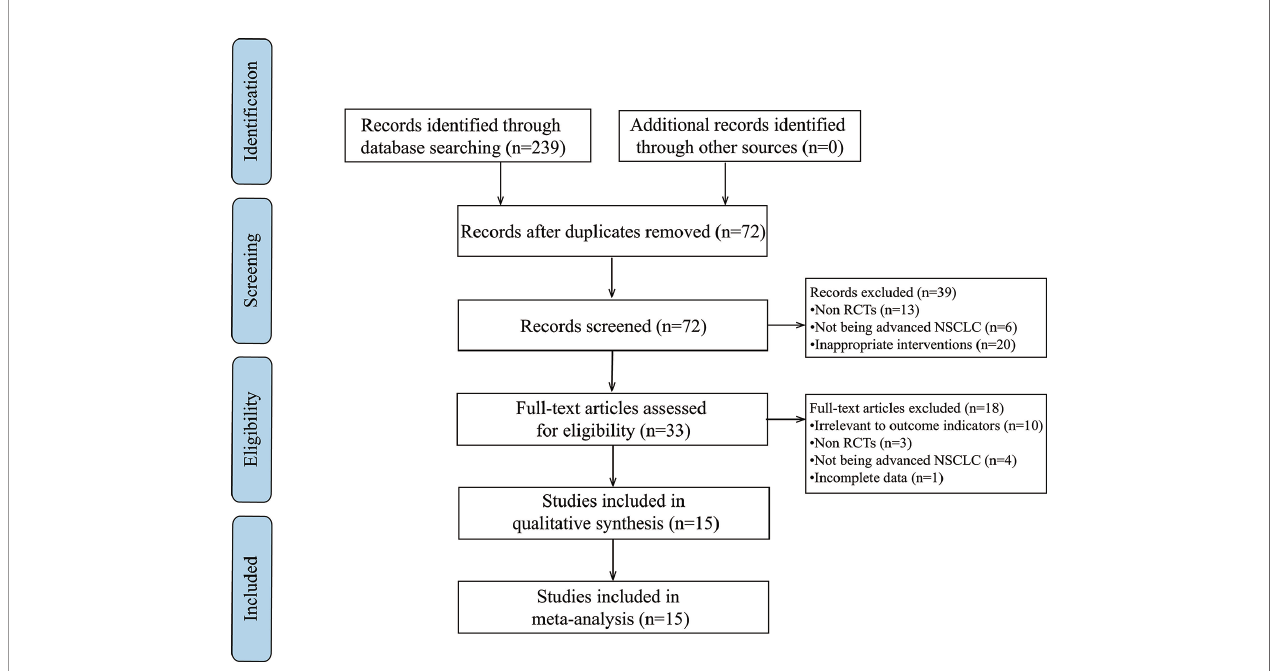
FIGURE 1 | PRISMA fl ow diagram of the literature search